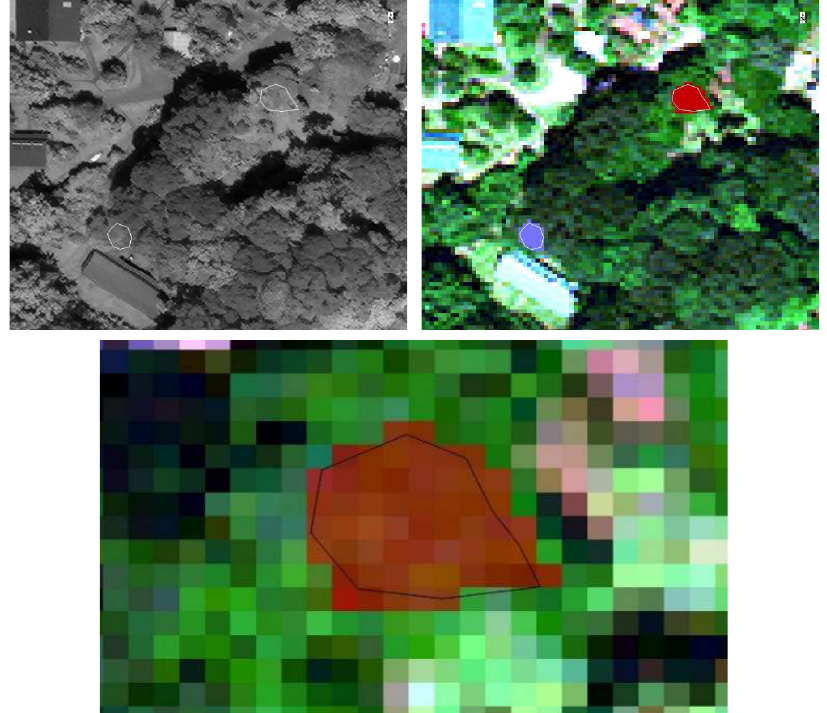
Figure 3. Data extractions for two tree crowns in La Selva. In the upper right image, the purple polygon represents a crown extraction from S. microstachyum and the red polygon is a P. macroloba extraction. The upper left image shows the extraction areas superimposed on the WorldView-3 panchromatic image. The image directly above is a closer view of the crown extraction for P. macroloba showing the individual multispectral pixels within the defined crown sample.